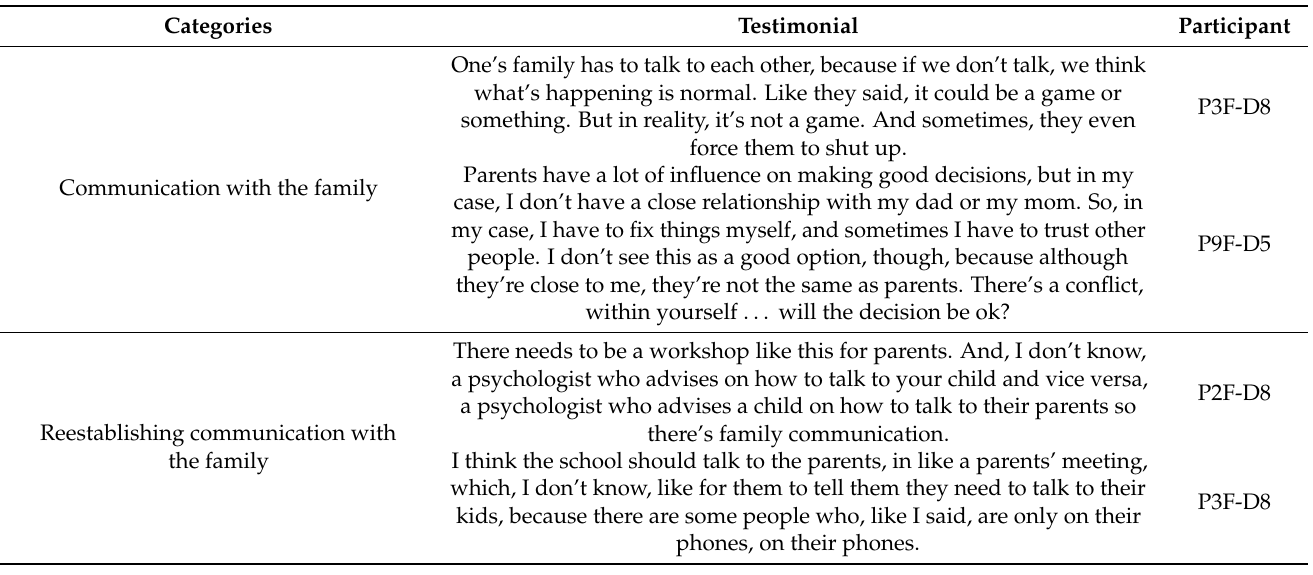
Table 5. Personal and familial actions recommended to prevent dating